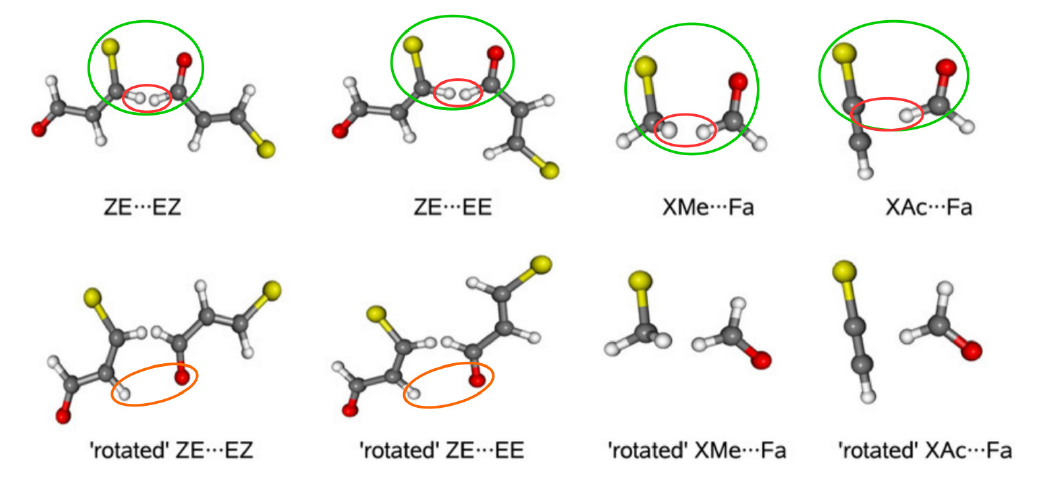
Figure 19. Spatial arrangement of reference dimers and their ‘open’ forms used in estimating the interaction energies of intramolecular X · · · O contacts in ZZ-3-halogenopropenal [74].